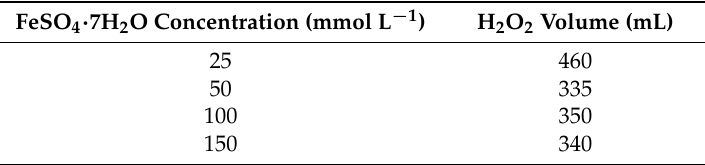
Table 1. Experimental conditions in 10 g resins oxidation